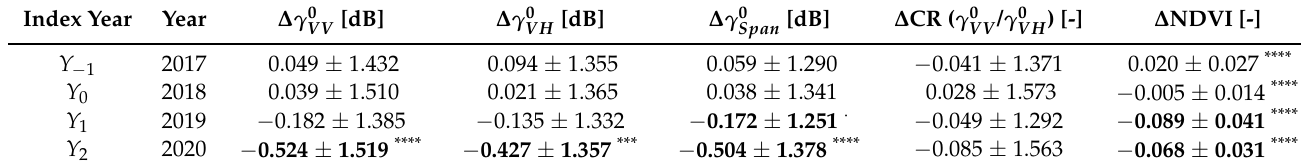
Table 1. Damage anomaly (mean ± SD) for S-1 variables and S-2 NDVI during the growing season. Two sample Welch tests of p -value significance levels are given as follows: < 0.0001 = **** , < 0.001 = *** ,